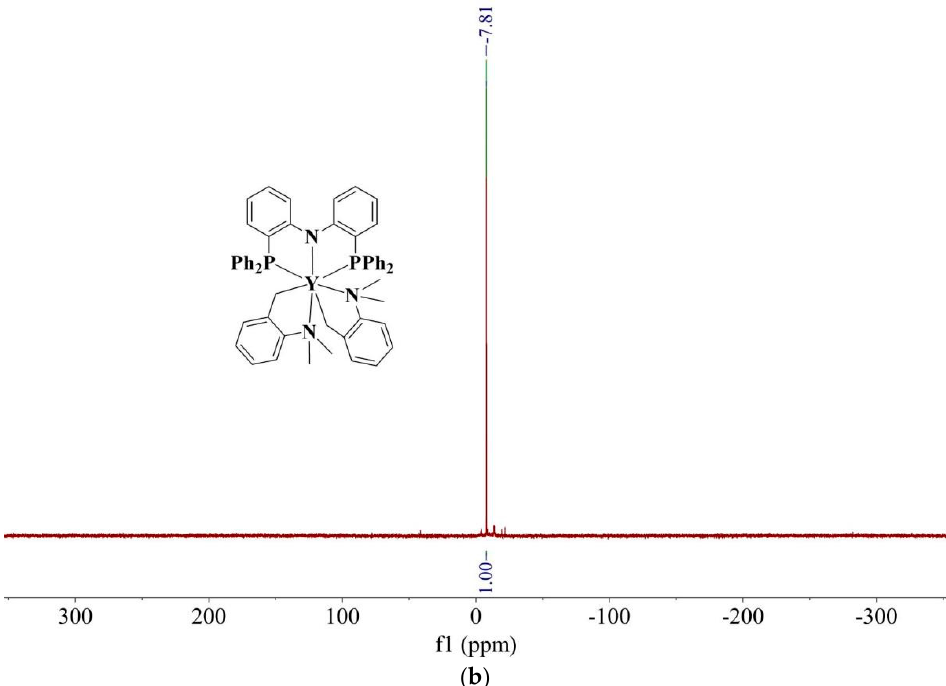
Figure 1. 1 H and 31 P NMR spectra of complex 1 . ( a ) Proton NMR spectrum of complex 1; ( b ) 31 P NMR spectrum of complex 1 .